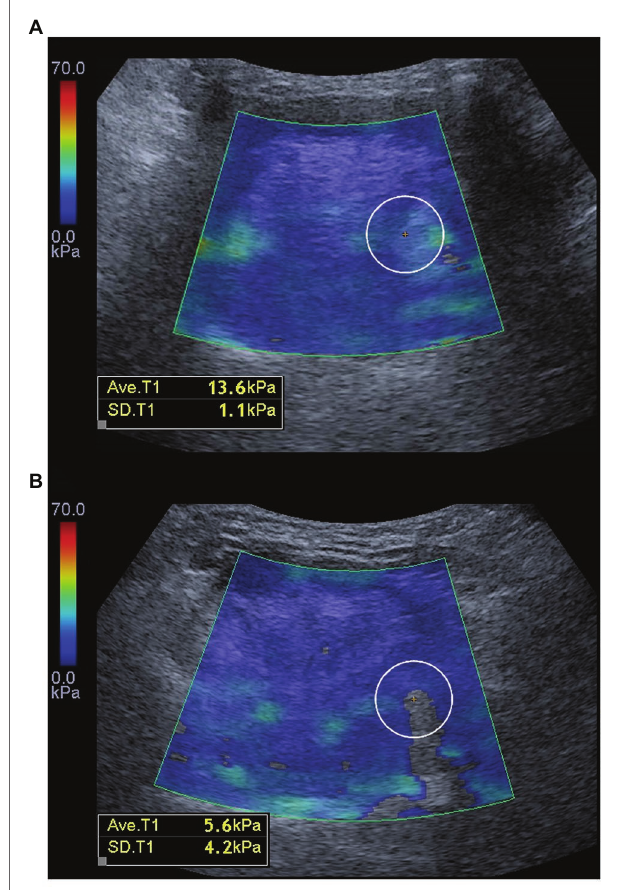
FIGURE 6 | A color filling defect in the elastogram (A) can lead to underestimation of the actual stiffness (B) of the target